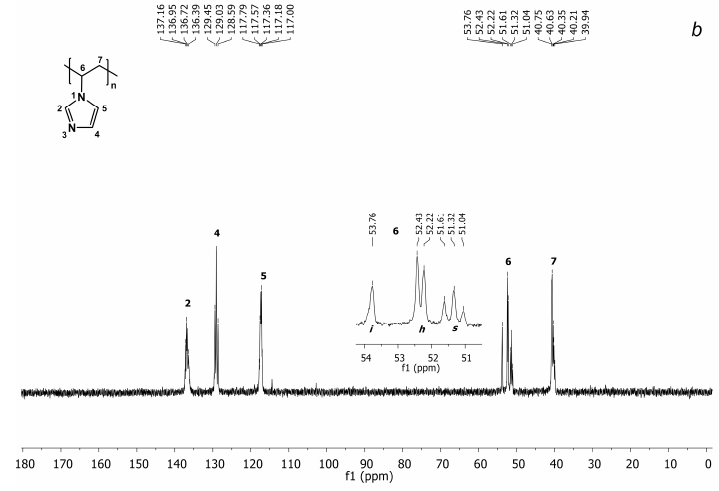
Figure 2. 1 H ( a ) and 13 C ( b ) NMR spectra of PVI.